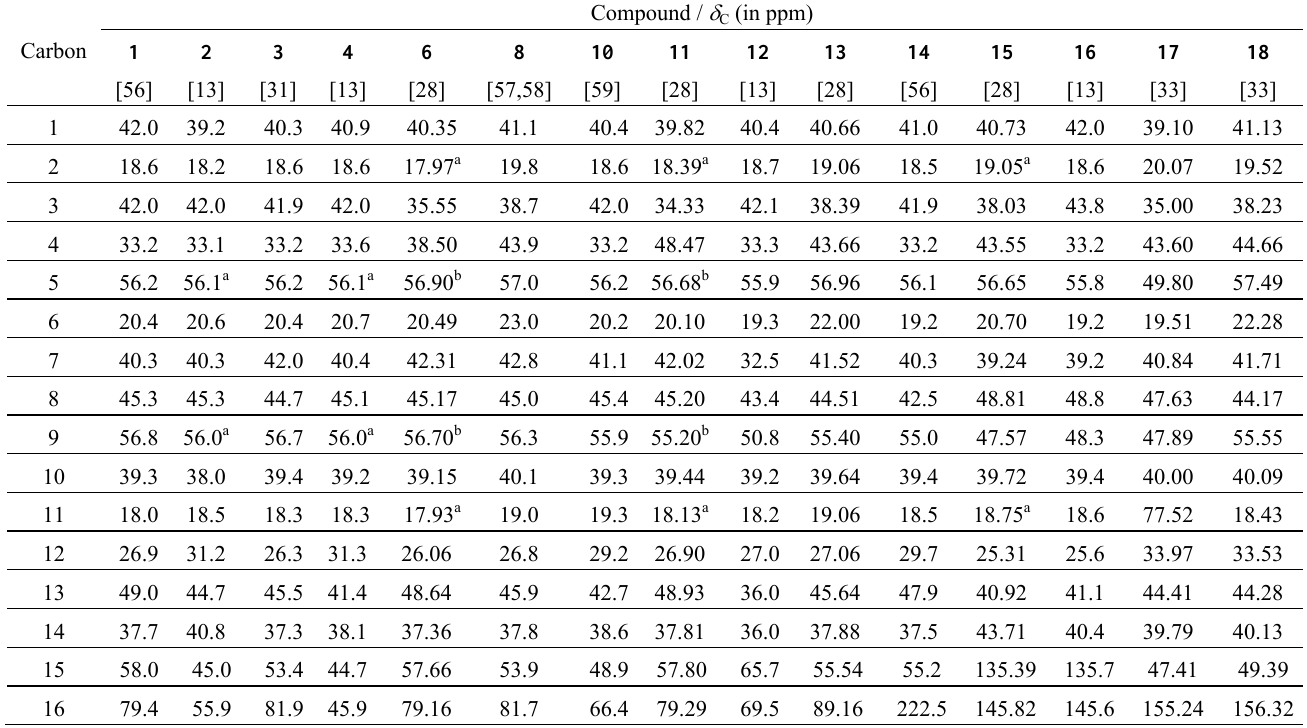
) of diterpenes from Aristolochia 3